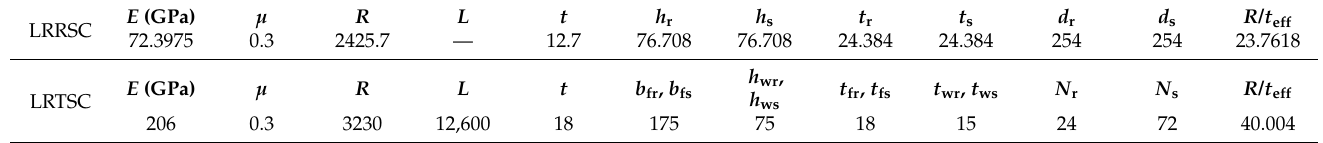
Table 7. Geometric and material properties of longitudinal ring stiffened